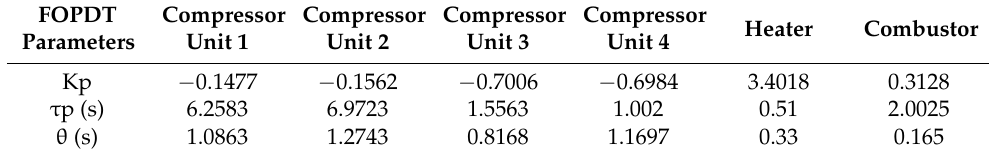
Table 2. FOPDT parameters from previous research.